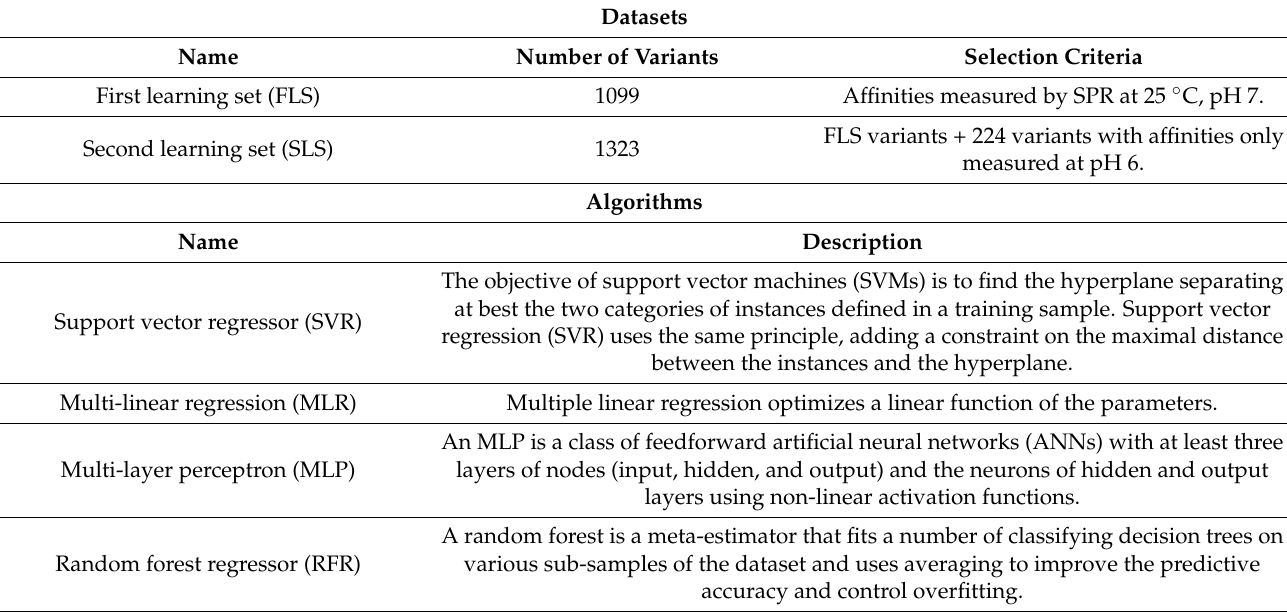
Table 1. Datasets and machine learning methods